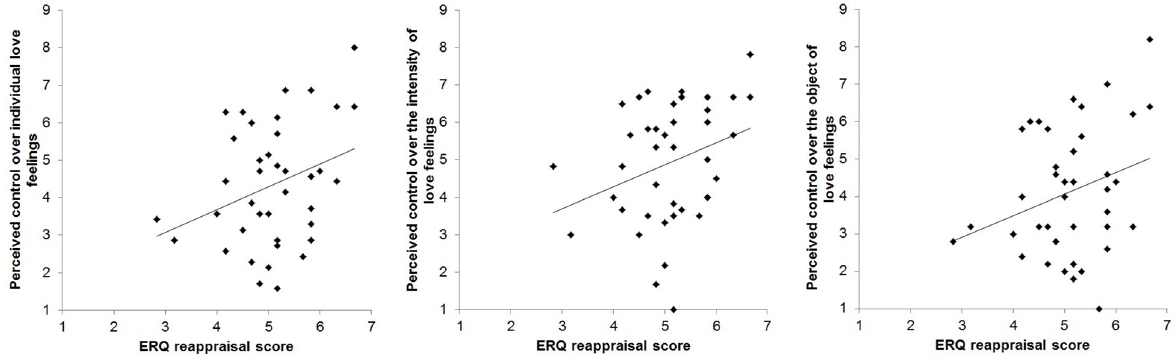
Fig 2. Scatterplots displaying the positive correlations between the ERQ reappraisal score and perceived control over various aspects of love feelings.